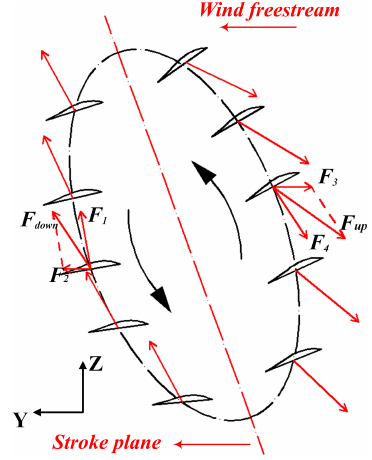
Figure 9. Wing tip path and aerodynamic force vector.